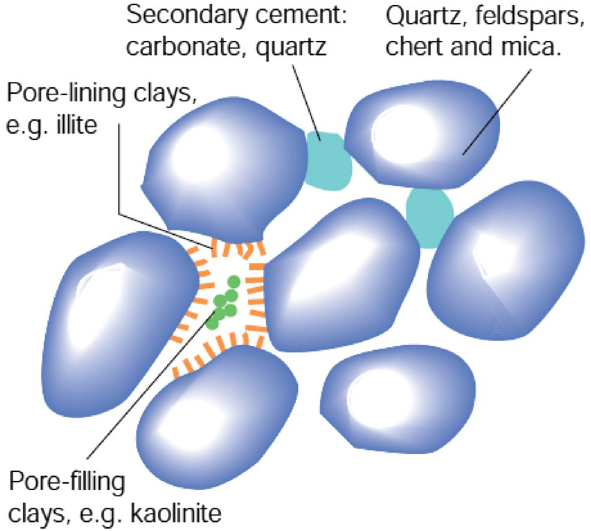
Fig. 3 Constituents of sandstone, all of which are soluble in HCl–HF mud acid system as described by Crowe et al. (1992)